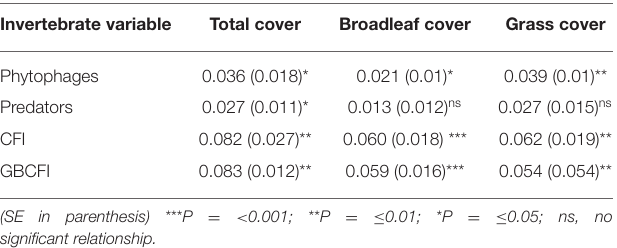
TABLE 9 | Weed cover required to provide a CFI of 0.7 (the minimum needed to maintain gray partridge numbers), in winter wheat.